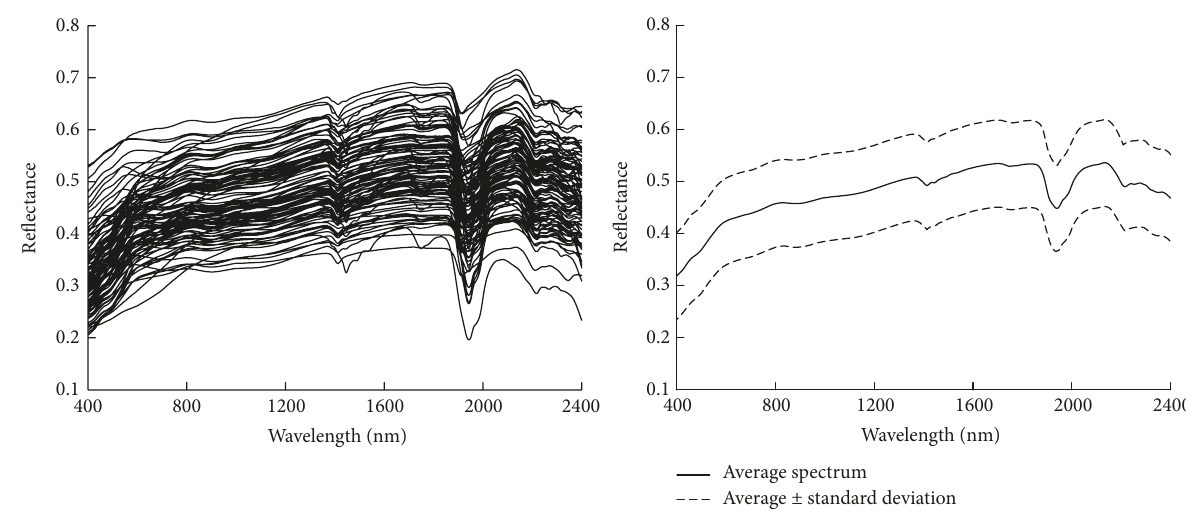
Figure 2: Spectral re fl ectance of soil samples after processing.